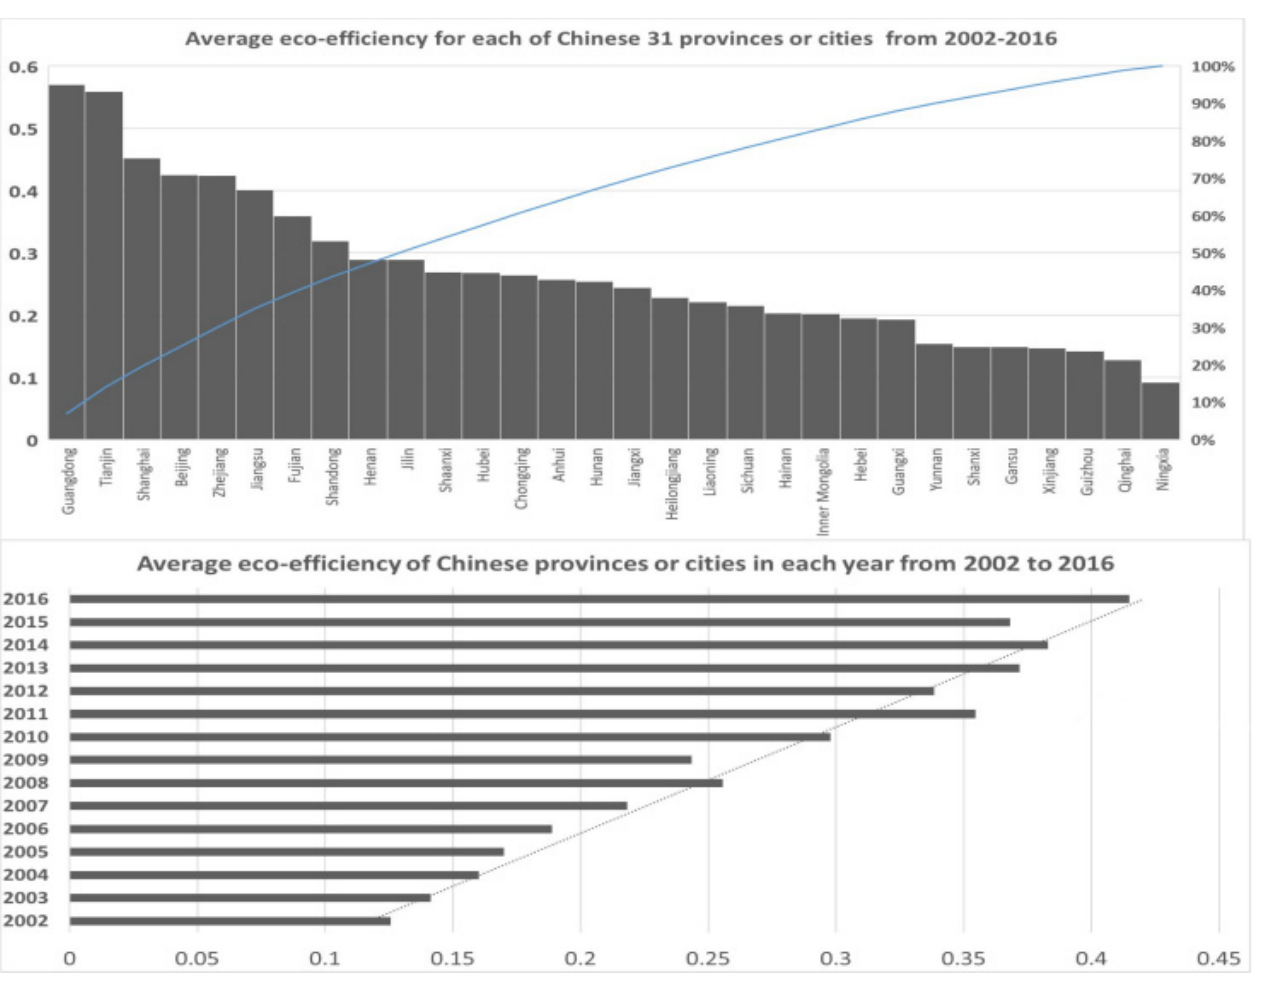
Figure 1. The values of REE in 30 provinces and cities of China.